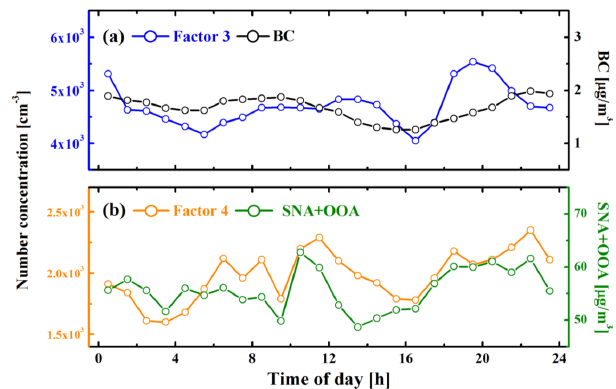
Figure 8: Diurnal variations of (a) particle number concentration of factor 3 (blue) and BC concentration (black); and (b) particle number concentration of factor 4 (orange) and the sum of sulfate, nitrate, ammonium and oxygenated organic aerosol organic concentration (olive).